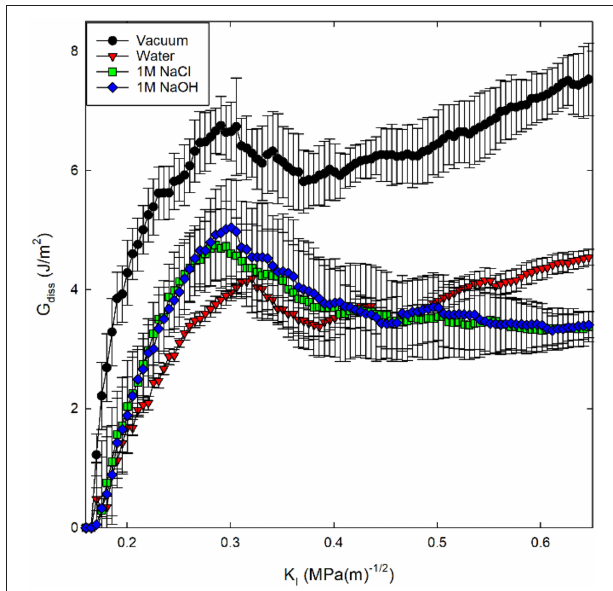
FIGURE 8 | Energy dissipation (G diss ) during crack loading and subsequent crack propagation for silica systems in four environmental conditions. G diss is calculated from Equation